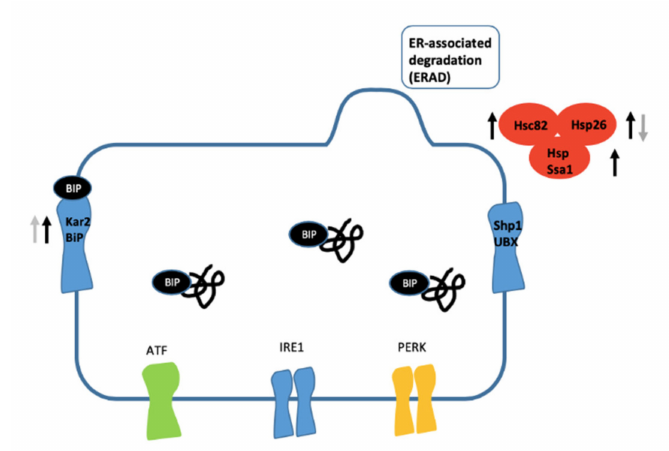
Figure 7. Protein processing in the Endoplasmic Reticulum (ER) pathway. Black arrows are for the proteins found with iTRAQ after 9 h treatment, grey arrows are for the proteins found after 24 h treatment. Arrows pointing up indicate upregulated proteins, arrows pointing down indicate downregulated proteins.